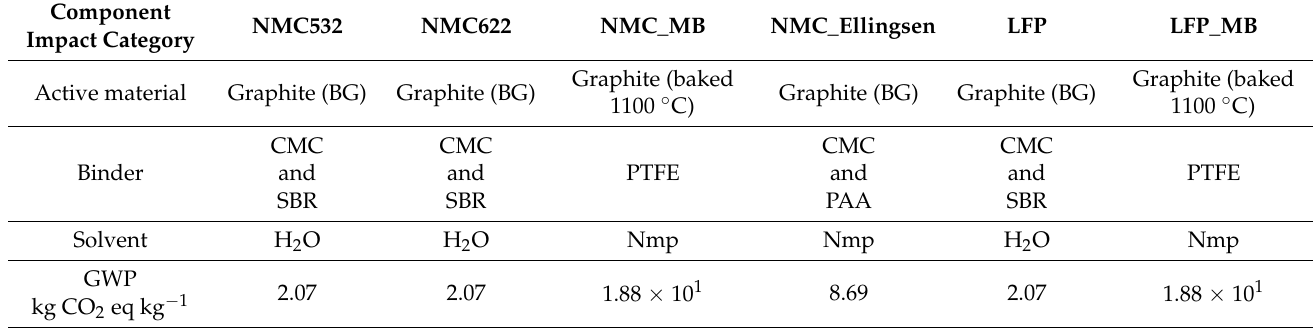
Table 6. Negative electrode composition for different cells and climate change (kg CO 2 eq) impacts for the production of 1 kg of binder for the negative electrode (BG: battery grade; Nmp: N-methyl-2-pyrrolidone; SBR: styrene–butadiene